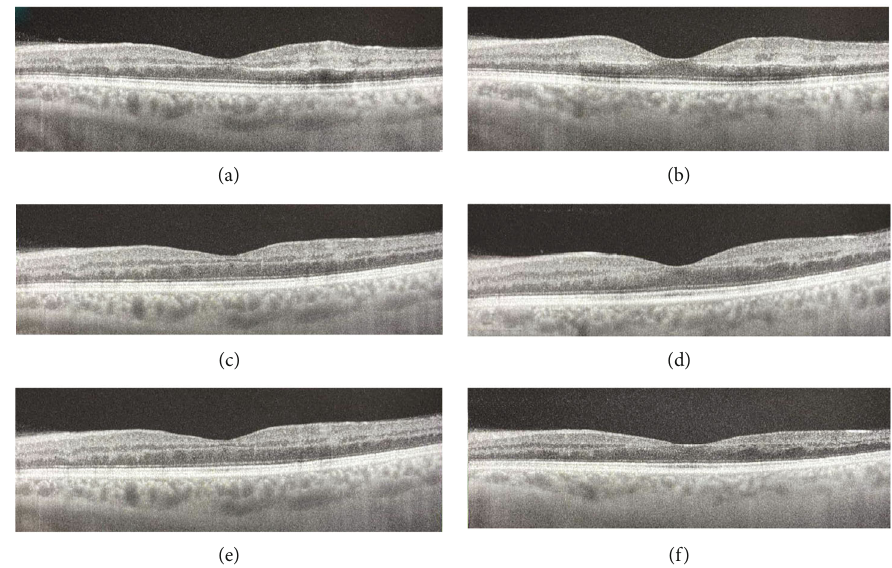
Figure 2: Swept-source- (SS-) OCT imaging of the left eye. Horizontal scans are presented on the left column and vertical ones on the right one (lines 1 and 6 on DRI OCT Triton, SS-OCT, respectively). OCT scans on presentation demonstrated di ff use, hyperre fl ective lesions at the level of the inner plexiform layer, inner nuclear layer, and outer plexiform layer (a, b). Partial resolution (one month later) (c, d) and complete resolution (six months later) (e, f) of the lesions are observed along with thinning of the inner